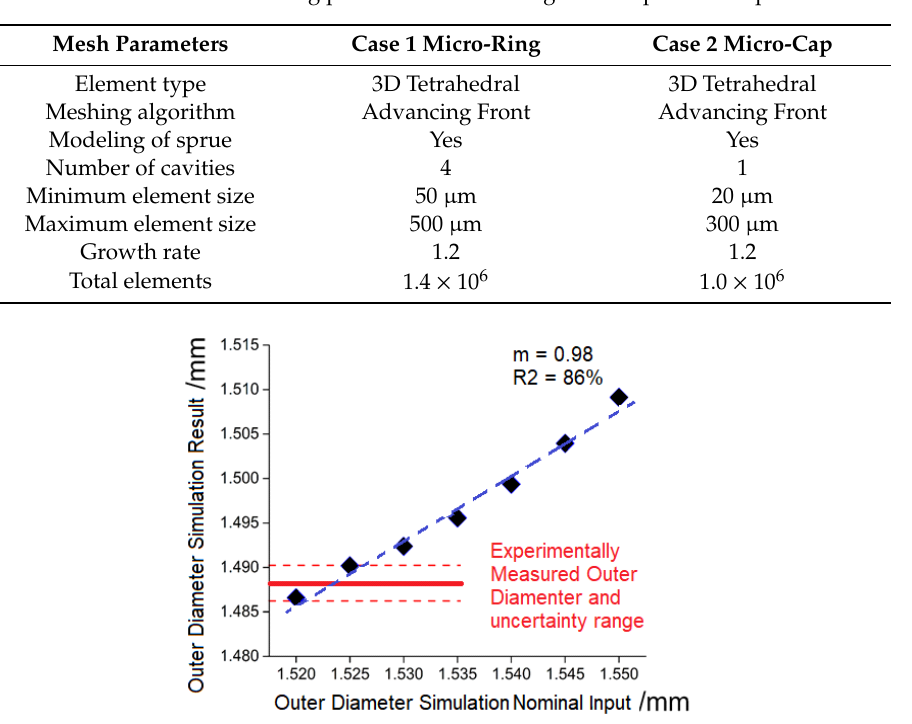
Figure 5. Multi-scale mesh and modified model geometry of Case 2 to include the flash formation in the simulation of the micro-cap [31]. Table 3. Multi-scale meshing parameters for the single micro-plastic components.